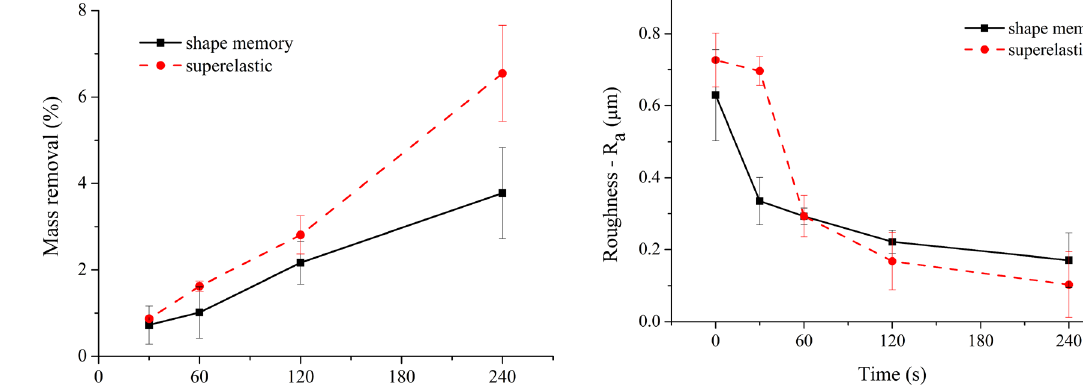
Figure 4. Average surface roughness (R polishing NiTi wires in 3.5 mol•L -1 methanolic H different